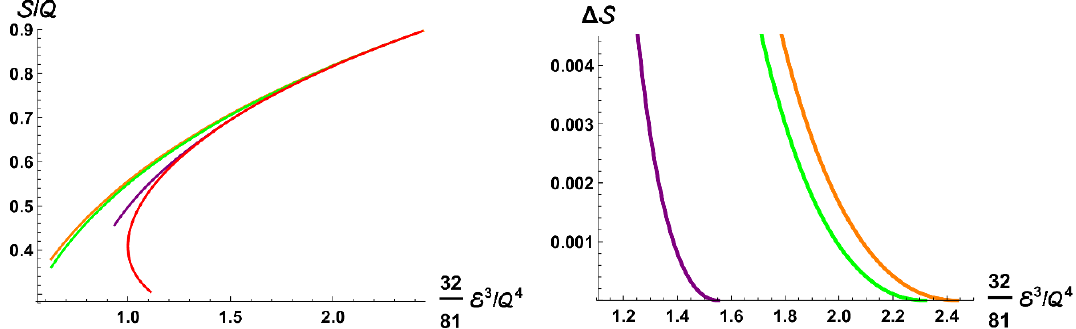
Z 2 symmetric phase; the (cid:8) (cid:9) 0 ; 1 ; 1 . The right 3 2